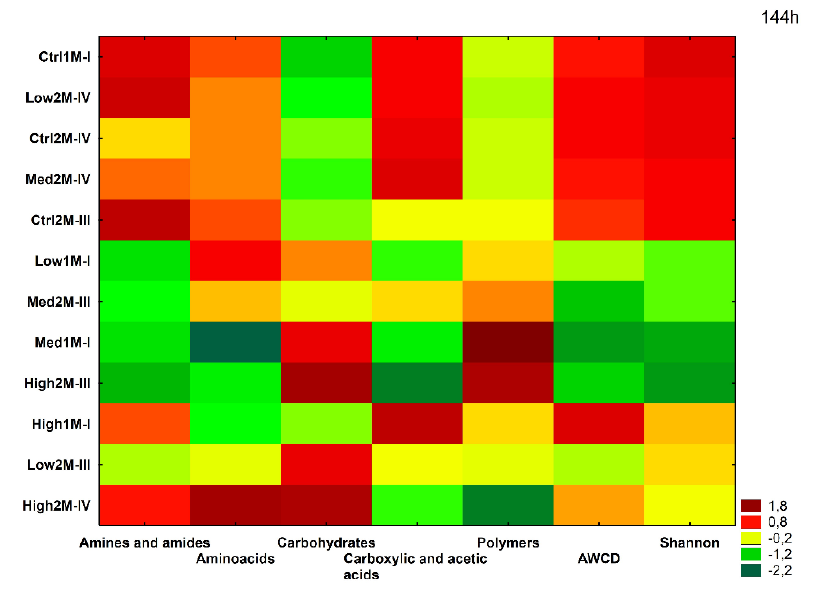
Figure 2. Average use of groups of carbon substrates based on readings in the 144 h of incubation. Ctrl, Low, Med, High—optimal moisture and low, medium and high water stress, respectively; 1M, 2M—month of the experiment; I, III, IV—sampling time.